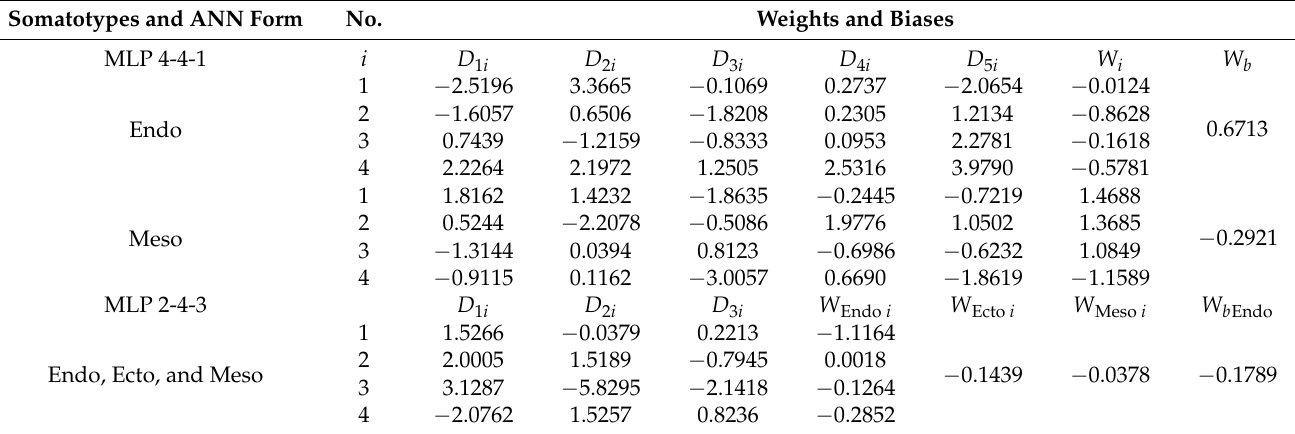
Table 3. Weights and biases between input and hidden layers and between hidden and output layers for artificial neural network (ANN) Endo, Ecto, and Meso